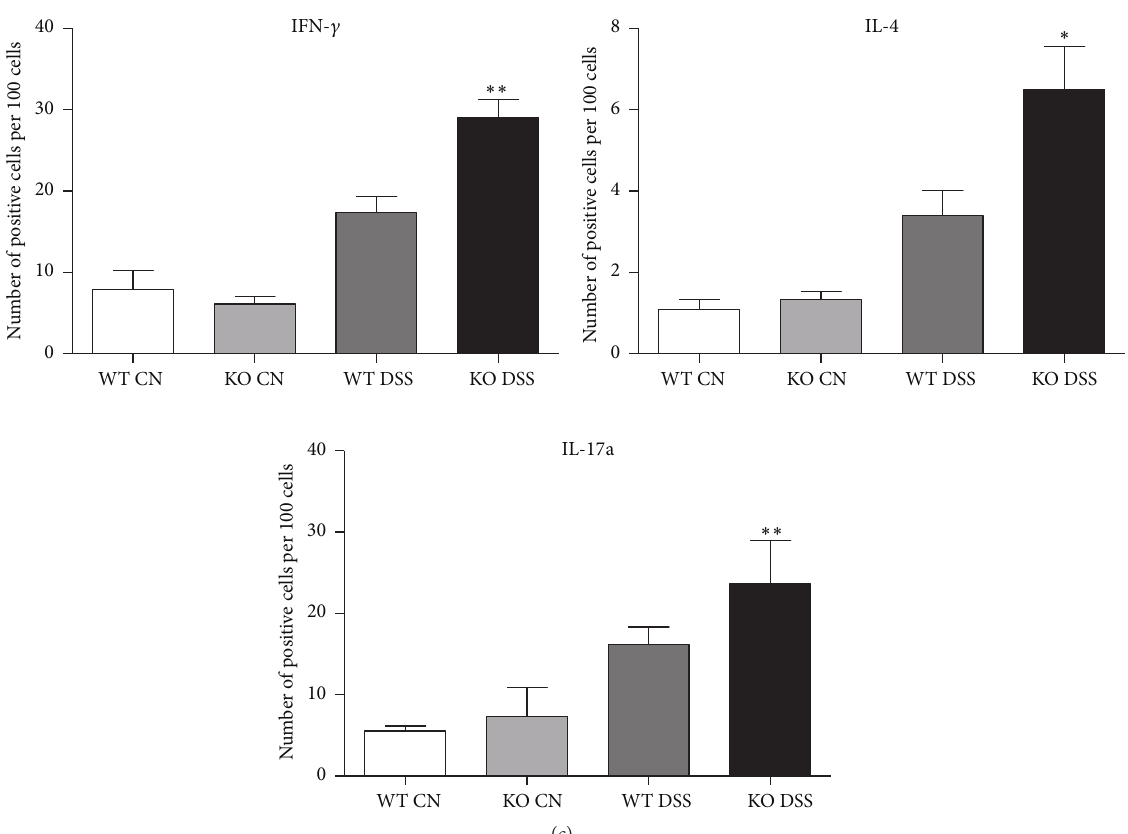
Figure 4: Deletion of TRAF5 increases the protein expressions of the cytokines IFN- 𝛾 , IL-4, and IL-17a in the colons of mice induced by DSS. (a) The production of IFN- 𝛾 , IL-4, and IL-17a in the colons of DSS-induced mice or control mice was examined by ELISA ( 𝑁 = 6 per group). (b) Representative immunofluorescence staining for IFN- 𝛾 , IL-4, and IL-17a in the colons of TRAF5 KO and WT mice (magnification 400x). (c) Quantification of positive cells ( 𝑁 = 4 per group). The data are representative of 3 independent experiments (mean ± SD). ∗ 𝑝 < 0.05 versus the DSS-treated WT group; ∗∗ 𝑝 < 0.01 versus the DSS-treated WT